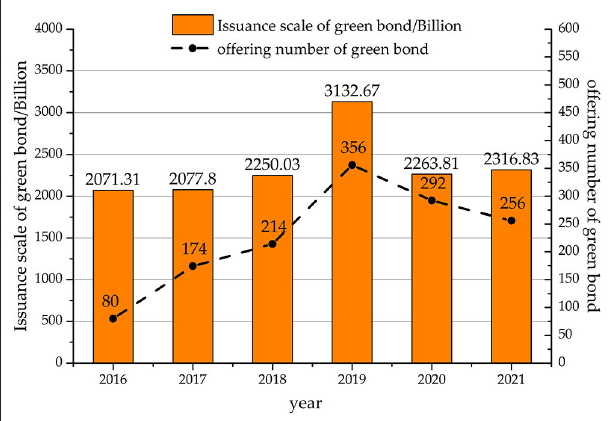
FIGURE 1 | Issuance scale of green bonds in